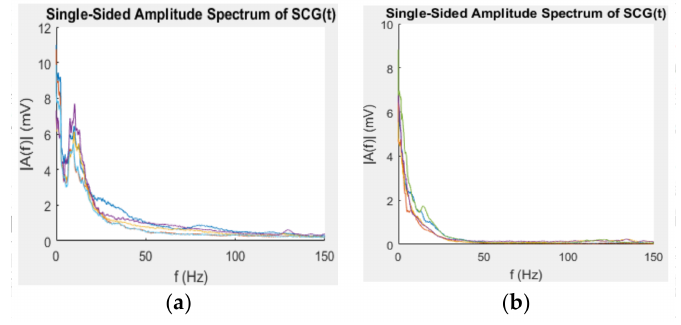
Figure 4. Spectrum of five subjects with ( a ) running and ( b )